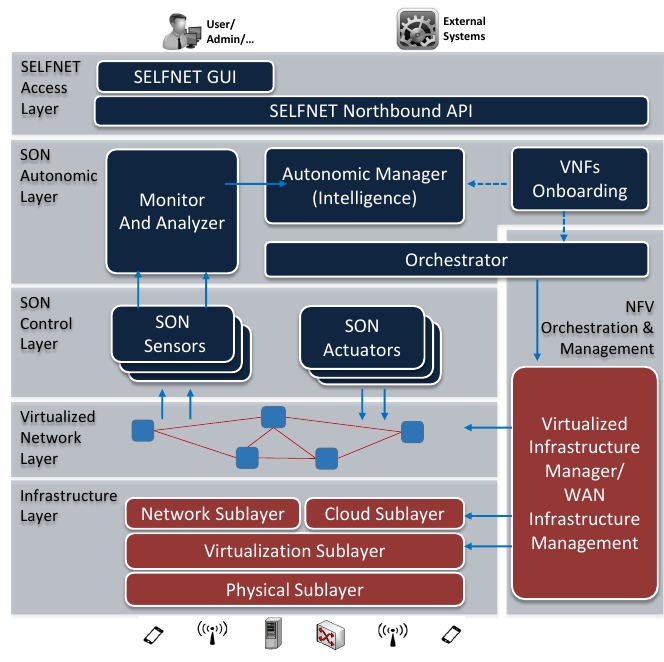
Figure 1. The SELFNET project